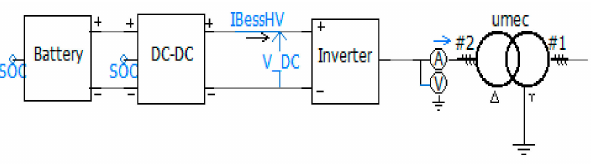
Figure 7. ESS model.